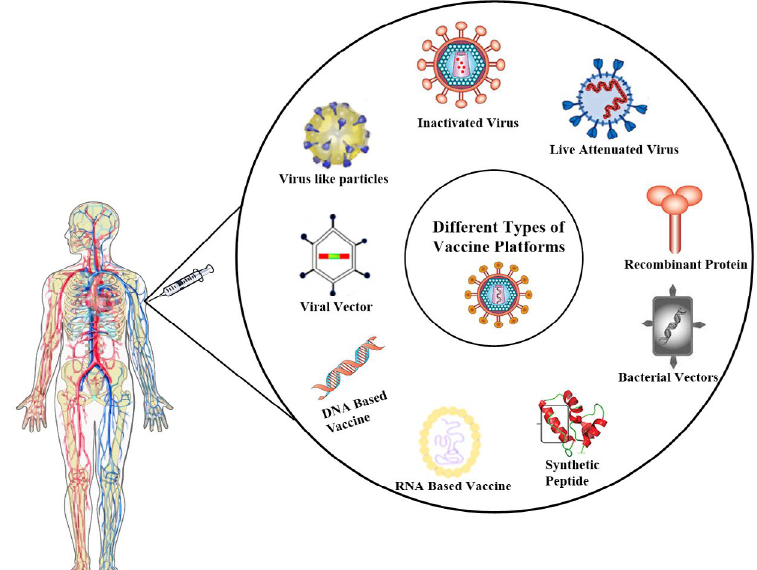
Figure 1. Different types of vaccination platforms for immunization. Vaccines can be developed using various platforms like an inactivated virus, live attenuated virus, recombinant-protein, bacterial vectors, synthetic peptides, RNA based, DNA based, viral vector, and virus-like particle [